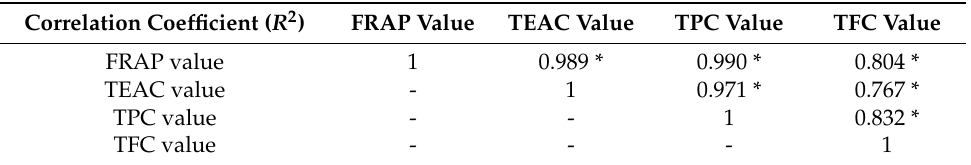
Table 2. Correlation analysis among FRAP, TEAC, TPC and TFC